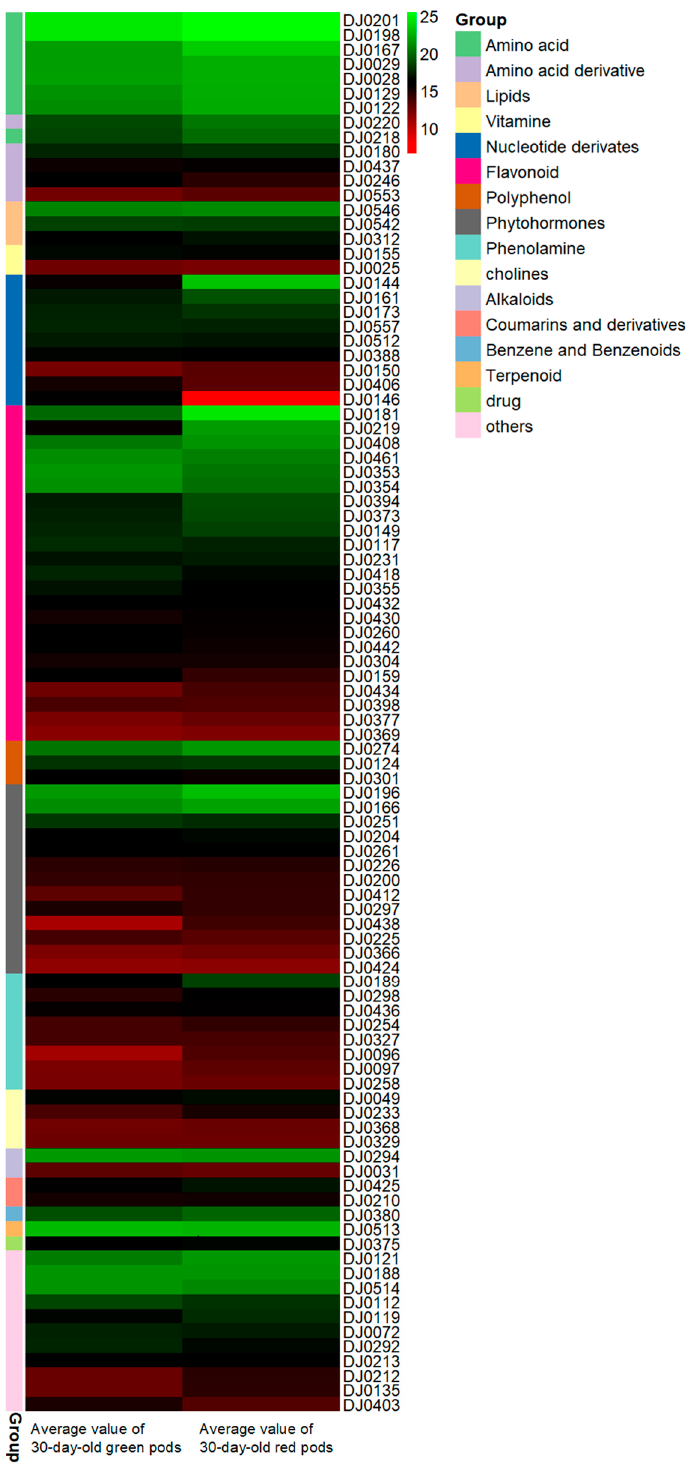
Figure 2. Significantly different metabolites in 30-day-old green ( left ) and red ( right ) pods. Significantly different metabolites of 30-day-old green and red pods after anthesis were assessed by variable important in projection (VIP) and fold change. Each different color rectangle on the left side of the heatmap represents one metabolite. The content of different metabolites in each class decreases from top to bottom in the samples. The numbers on the right side of the picture were the codes of the result of the LC-ESI-MS/MS, with specific information shown in Table S1. The names of different types of metabolites are displayed on the right side of the chart. The values in picture are the averages of three biological duplicate samples.